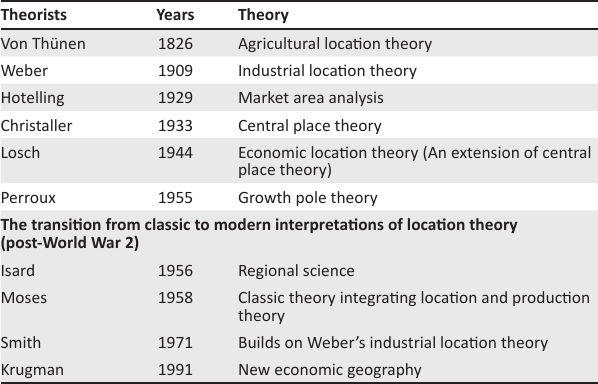
TABLE 8: The evolution of location